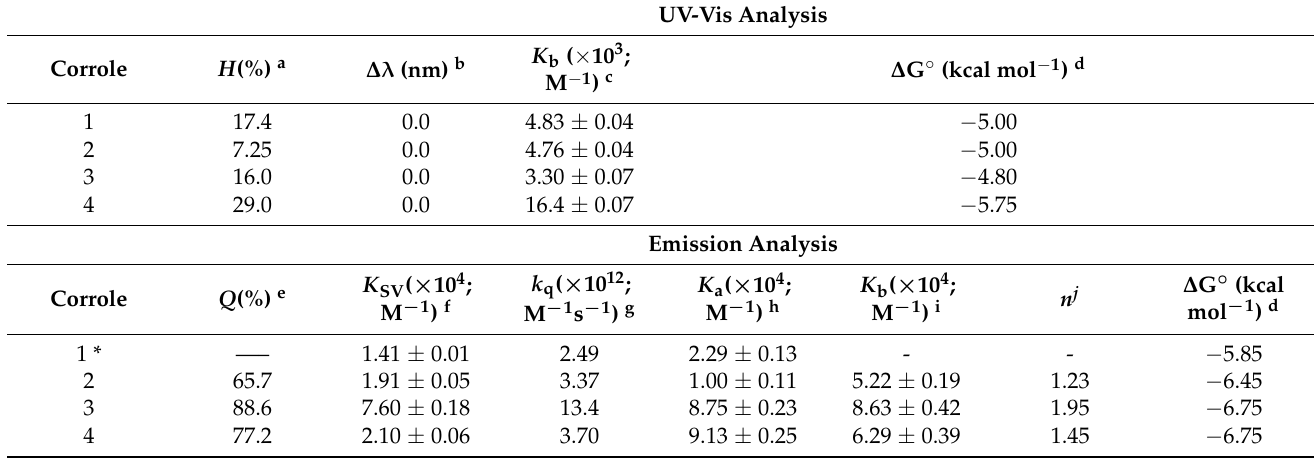
Table 6. HSA-binding properties of corroles 1 – 4 by UV-Vis and fluorescence emission analysis. UV-Vis